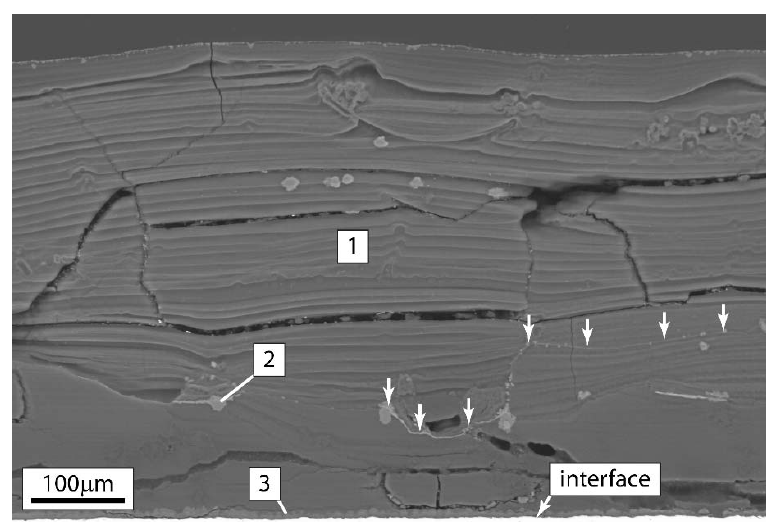
Figure 7. X-ray diffraction pattern.